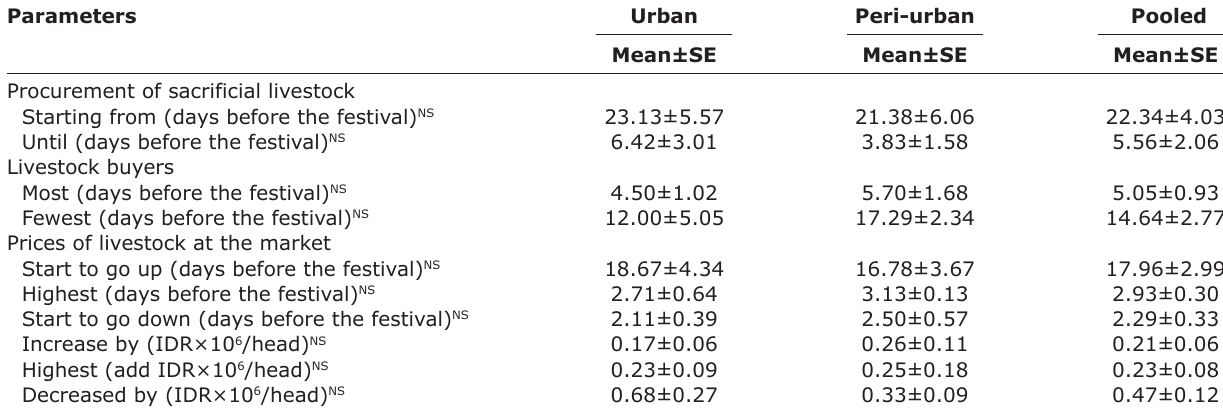
Table-2: Procurement, buyers, and prices of sacrificial livestock (sheep and goats) at roadside livestock trading during the Eid al-Adha period.